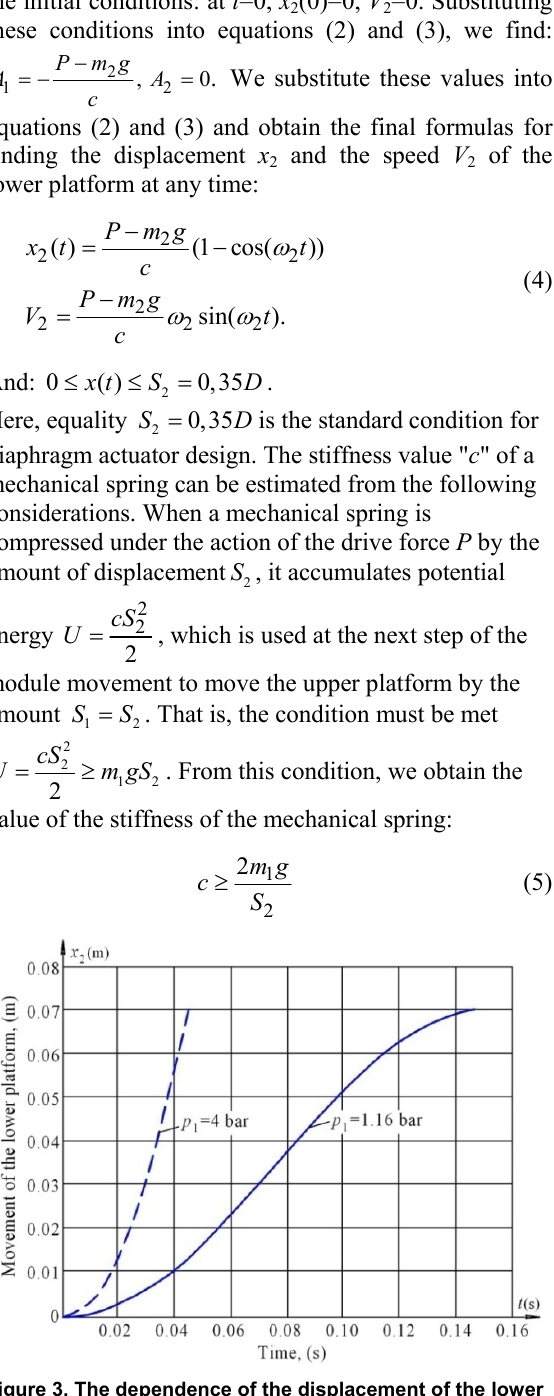
Figure 3. The dependence of the displacement of the lower platforms from time to time at different pressures p 1 in the diaphragm drive under the following conditions: D =0.2(m); d =0.04(m); S 2 =0.35 D (m); m 1 = m 2